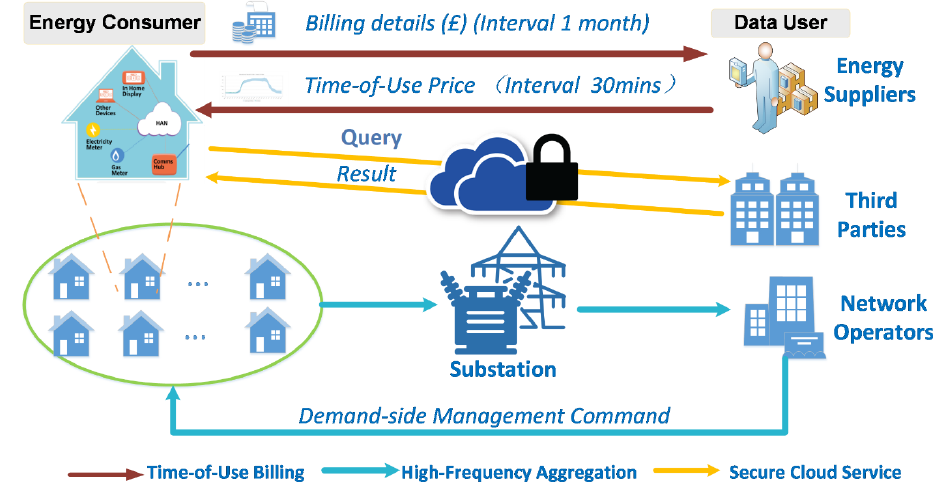
Figure 2. Proposed smart metering system.